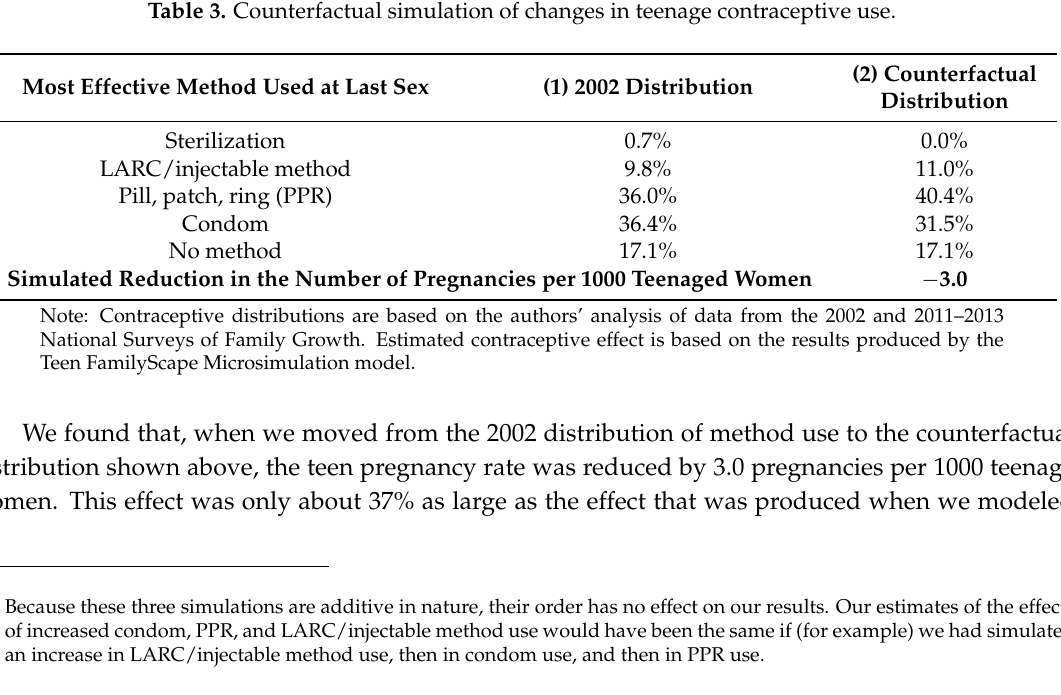
Table 3. Counterfactual simulation of changes in teenage contraceptive